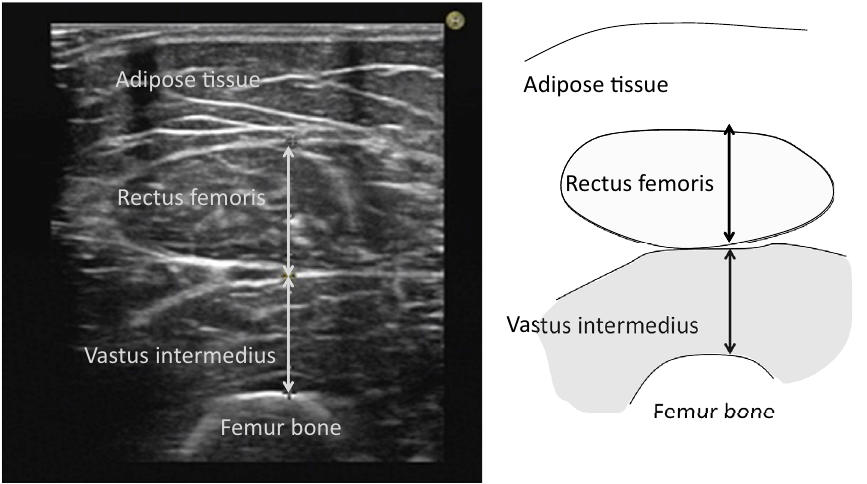
Figure 3. Ultrasound image of the rectus femoris and vastus